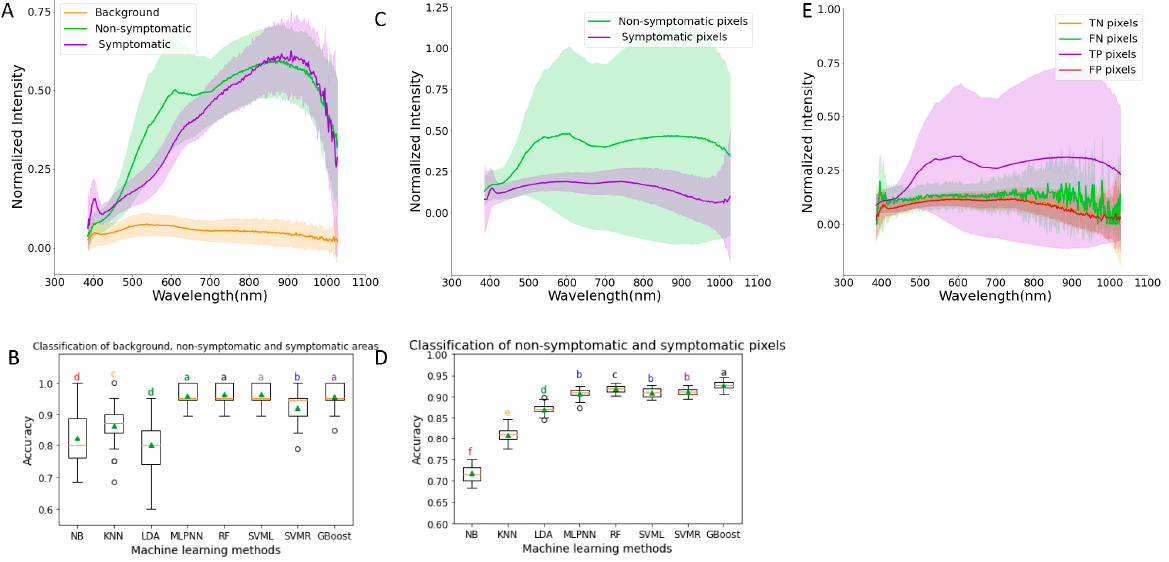
Figure 3. ( A ) Spectral profile of background, non-symptomatic areas, and symptomatic areas of wheat kernel hyperspectral images. ( B ) Comparison of the performance of eight machine learning methods to classify data points into background, non-symptomatic area, and symptomatic area classes. ( C ) Spectral profiles of low and severe pixels. ( D ) Comparison of the performance of eight machine learning methods to classify pixel data points into low and severe classes. ( E ) Spectral profiles of true negative (TN), false negative (FN), true positive (TP), and false positive (FP) pixels. NB = Gaussian Naïve Bayes; KNN = K-nearest neighbors; LDA = linear discriminant analysis; MLPNN = multi-layer perceptron neural network; RF = random forests; SVML = support vector machine with linear kernel; SVMR = support vector machine with radial basis function kernel; G-Boost = gradient boosting. All data in ( A , C , E ) are normalized with a maximum value of 1.0. Letters a–f in ( B , D ) indicate statistical test results with same letter representing that the difference is not statistically signi fi cant.